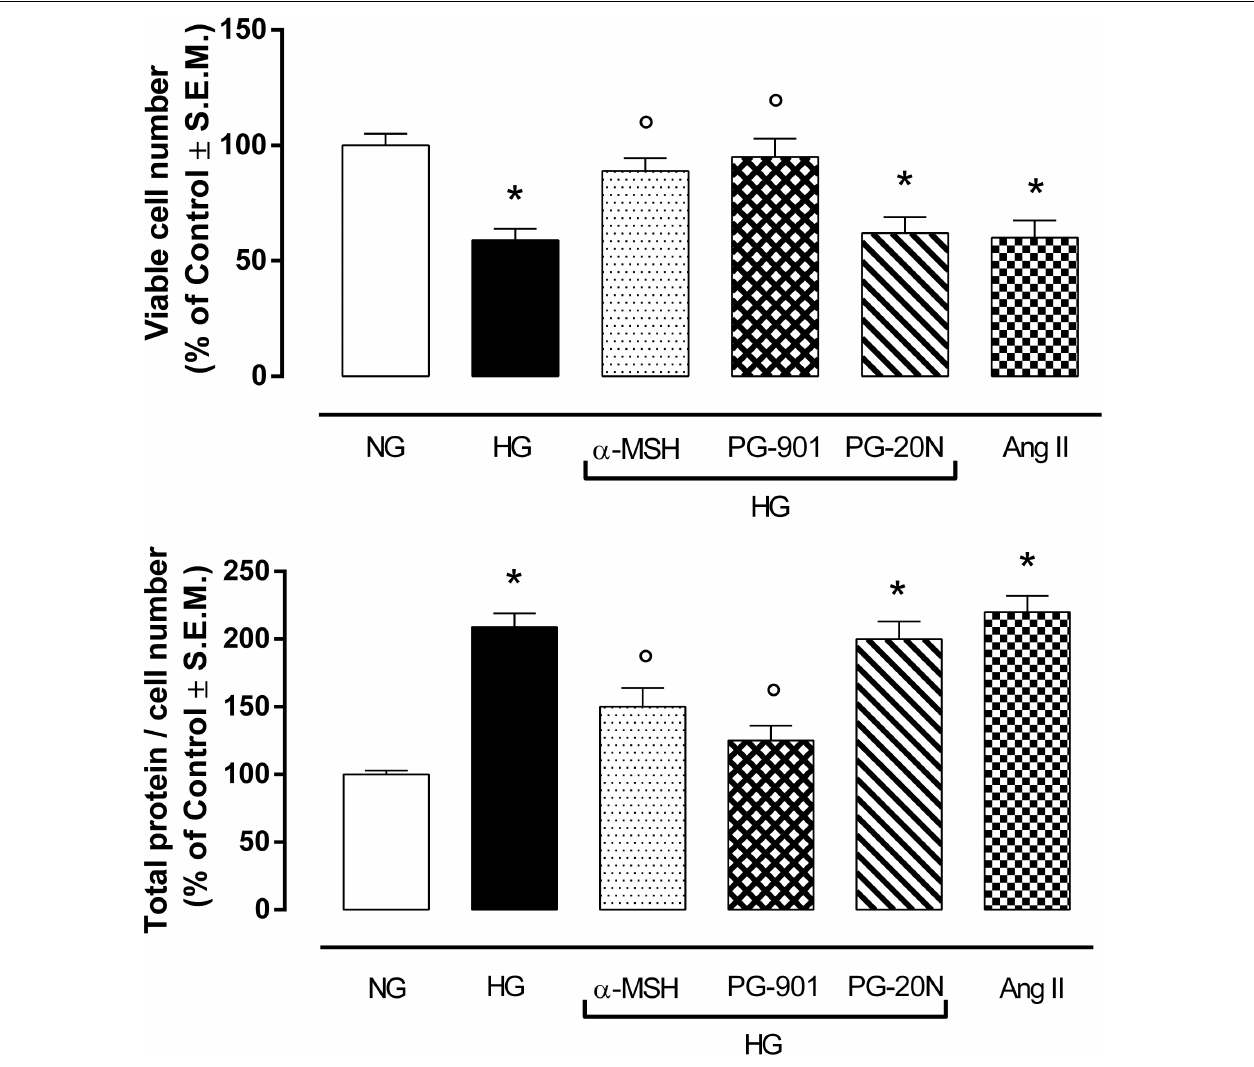
FIGURE 4 | MTT assay and determination of total protein / viable cell number at direct cell counting. H9c2 cells exposed to high glucose (33 mM D -glucose) exhibited a significant decrease in cell viability and higher total protein / viable cell number ratio, as a marker of cardiac hypertrophy, compared to cell exposed to normal glucose (5.5 mM D -glucose). Agonism at MC5R with a-MSH (90 pM) and selectively with PG-901 (10 − 10 M) increased cell viability and decreased total protein / viable cell number ratio in cells exposed to high glucose. Cell viability values and total protein / cell number ratio exhibited by H9c2 cells exposed to high glucose were not affected by PG-20N MC5R antagonist (130 nM). Values are expressed as mean ± S.E.M. of n = 9 values, obtained from the triplicates of three independent experiments. NG, normal glucose; Ang II, angiotensin II; HG, high glucose; ∗ P < 0,01 vs. NG; ◦ P < 0,01 vs.